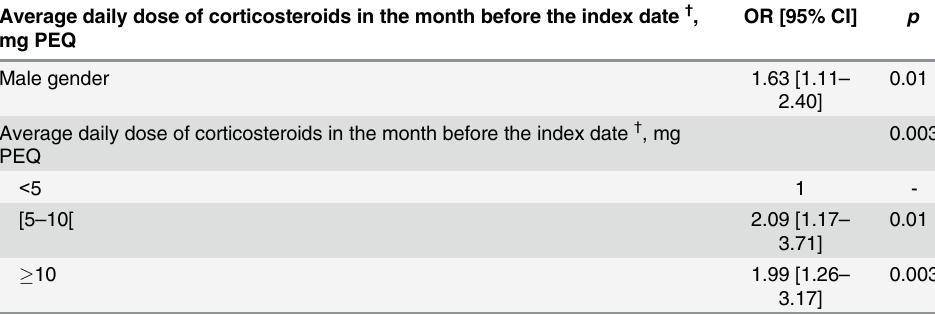
OR [95% CI] p 0.01 2.40] 0.003 0.01 0.003 3.17]